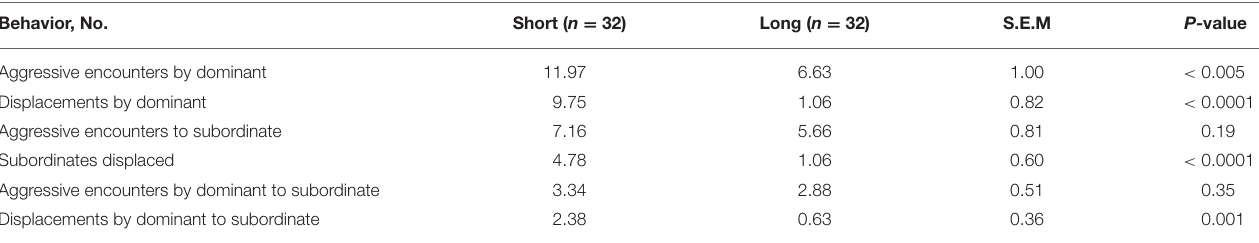
TABLE 3 | Numbers of aggressive encounters and displacements displayed by dominant and subordinate gestating sows housed in small group pens equipped with short and long length feeding barriers.